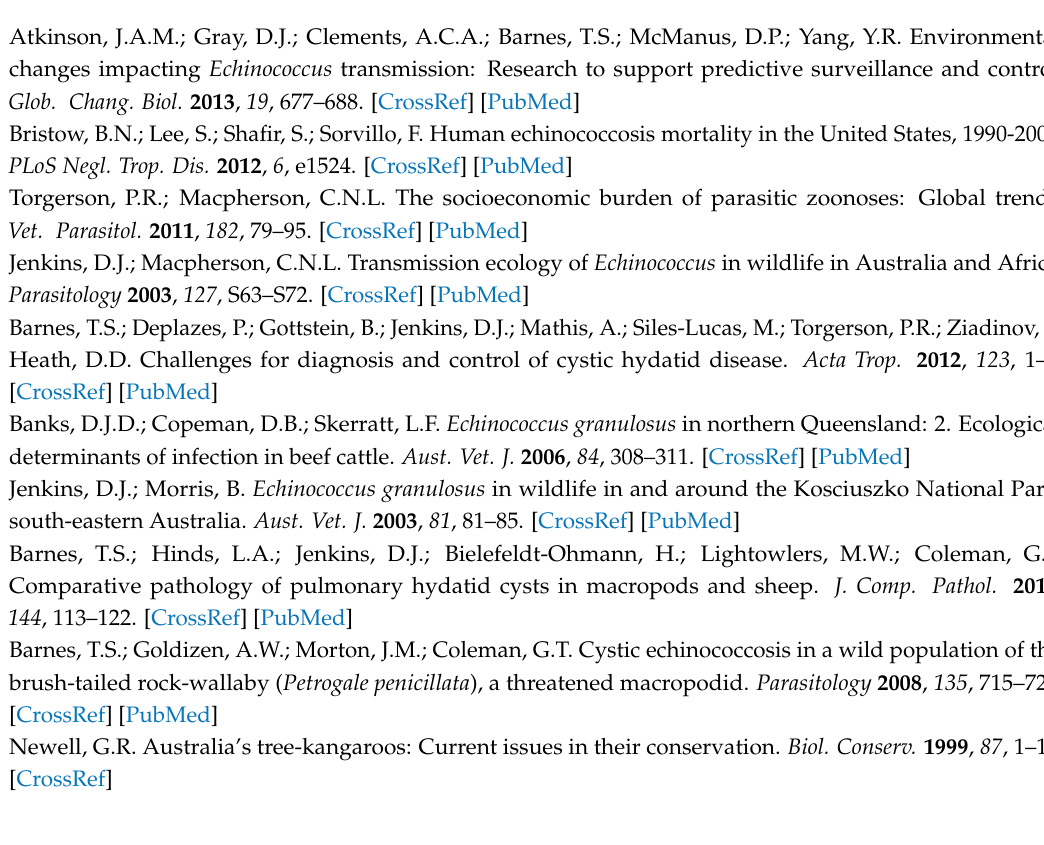
Figure S1: Male Lumholtz’s tree-kangaroo. Photo by J.